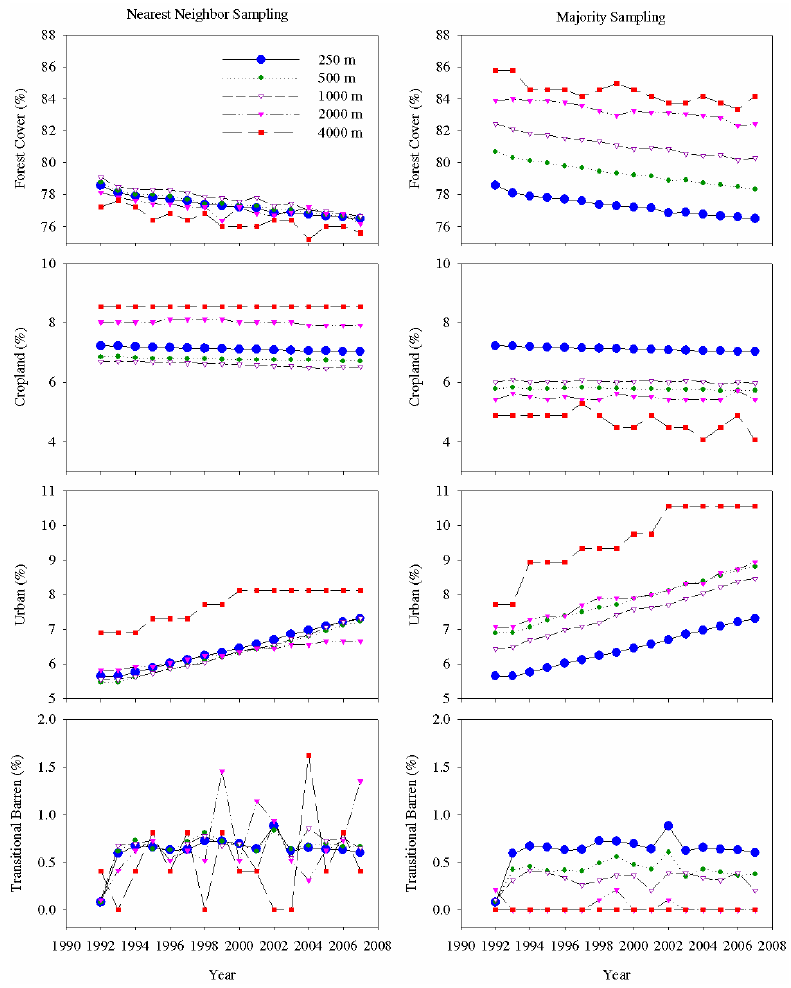
Fig. 2. Temporal changes in area percentage of forest, cropland, urban, and transitional barren from 1992 to 2007 at different spatial resolutions resampled using the nearest-neighbor and majority resampling